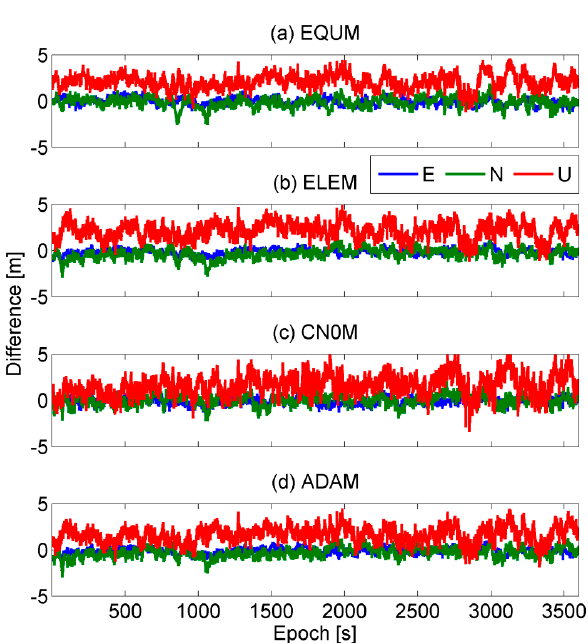
Figure 13. Positioning differences between the RTD solutions and the precise coordinates of dataset no. 2. ( a ) Results of the equal-weight model (EQUM); ( b ) results of the elevation model (ELEM); ( c ) results of the C/N0 model (CN0M); and ( d ) results of the adaptive model (ADAM).